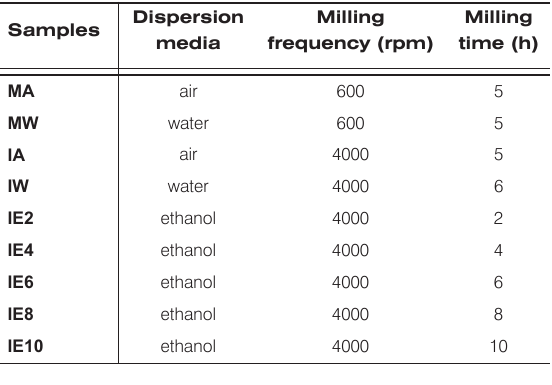
Table 1. Different samples made by milling in attritor